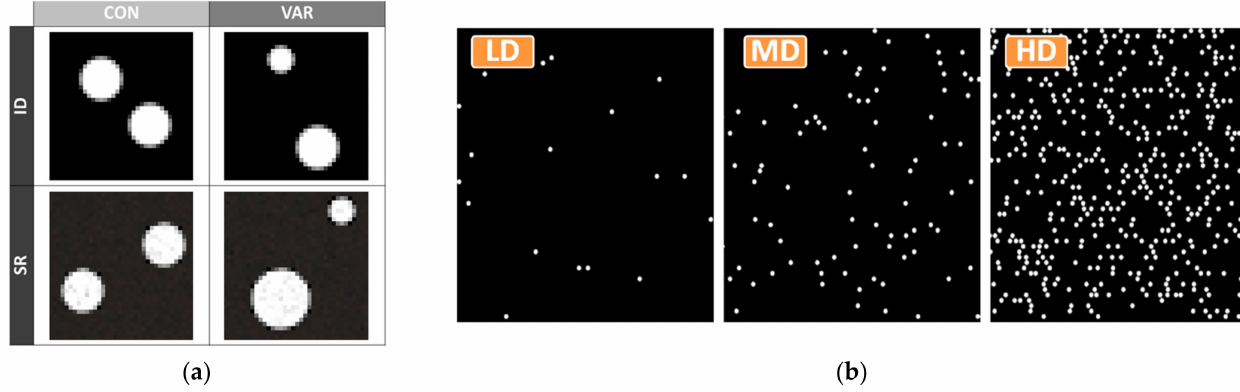
Figure 4. ( a ) Schematic representation of the 4 possible schemes (ID-CON, ID-VAR, SR-CON, S-VAR), obtained by combining the two different options for the tracer size ( constant size CON or variable size VAR) and the two environmental conditions ( ideal ID or semi-real SR). ( b ) A representative frame for the low (LD), medium (MD and high (HD) seeding density for the scheme